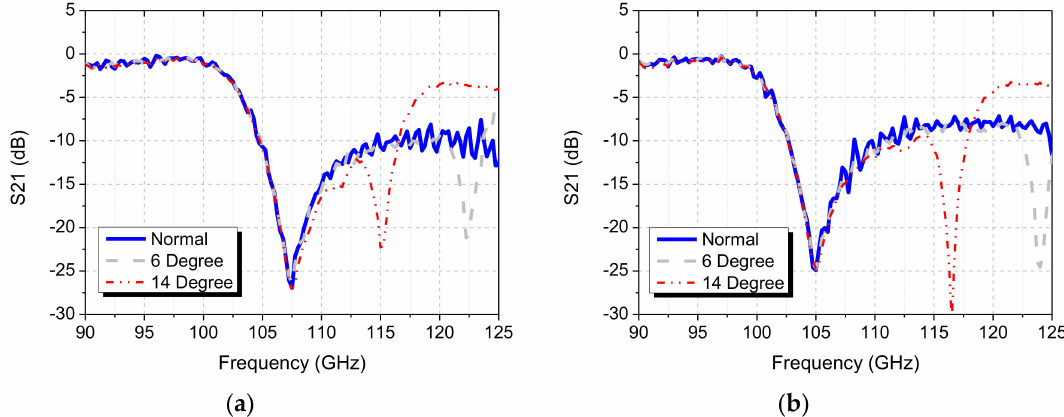
Figure 10. Measured angular performance: ( a ) Square-loop FSS Filter, ( b ) Circular-loop FSS